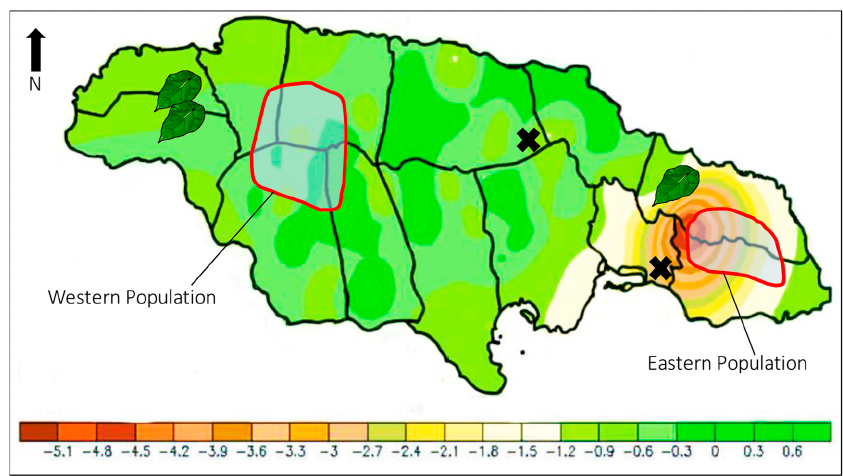
Figure 6. Map showing trend in rainfall in Jamaica from 1992 to 2010. The positive values indicate an increase in rainfall and negative values indicate a decrease (Data source: Meteorological Service of Jamaica). Areas outlined in red indicate the current range of Papilio homerus in the eastern and western populations, past populations or capture sites are shown with an X, and Hernandia images indicate areas where the host plant is available and could serve as a future site for P. homerus release sites if a breeding colony is established. Note the decrease in rainfall that overlaps the eastern population of P. homerus .